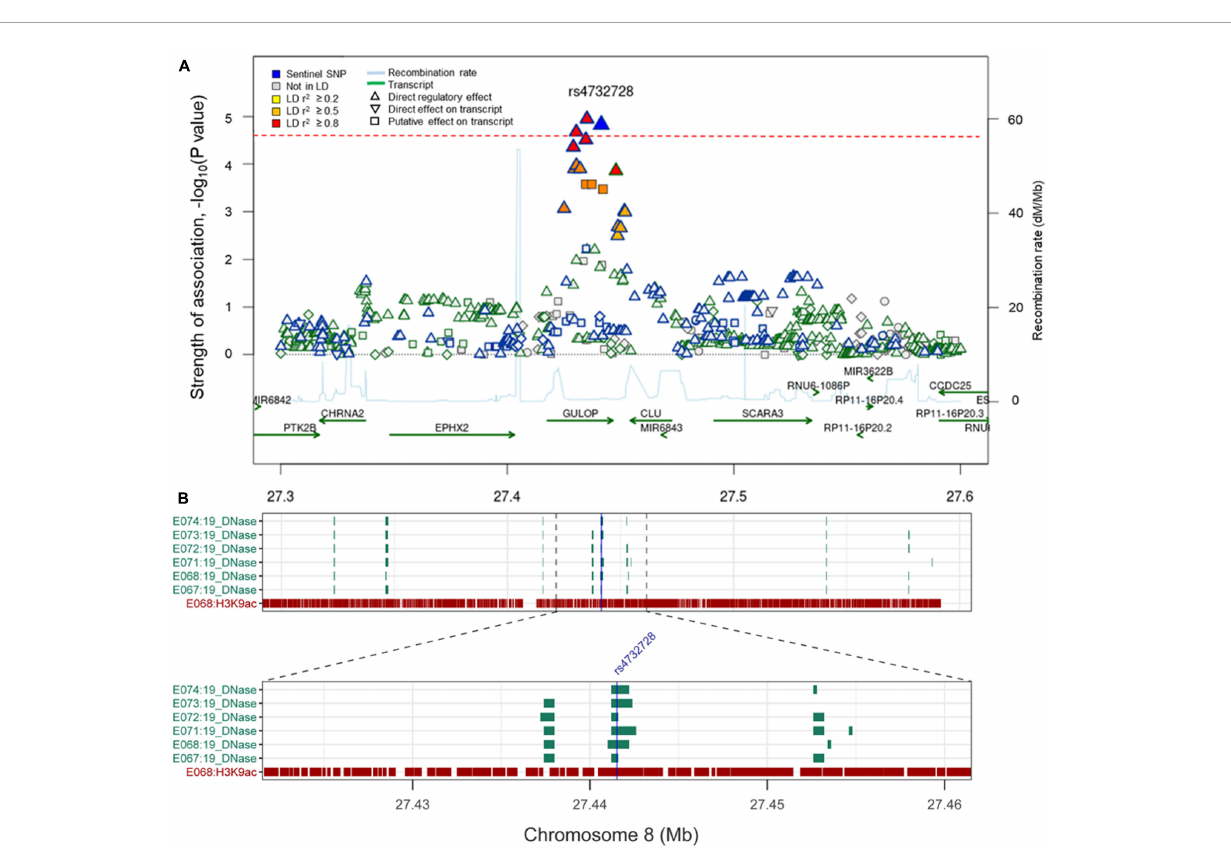
FIGURE2 (A) Regional association plot of rs4732728. The red dotted line indicates P- value threshold (1.96 × 10 - 5 ). P- values were calculated using the logistic regression with the interaction term (SNP × diagnosis). The figure was modified from the SNiPA (single-nucleotide polymorphism annotator) (https://snipa.helmholtz-muenchen.de/snipa3). (B) Chromatin state of rs4732728 in brain tissues. Brain angular gyrus (E067), brain anterior caudate (E068), brain hippocampus middle (E071), brain inferior temporal lobe (E072), brain dorsolateral prefrontal cortex (E073), and brain substantia nigra (E074). The figure was based on the Roadmap Epigenomics